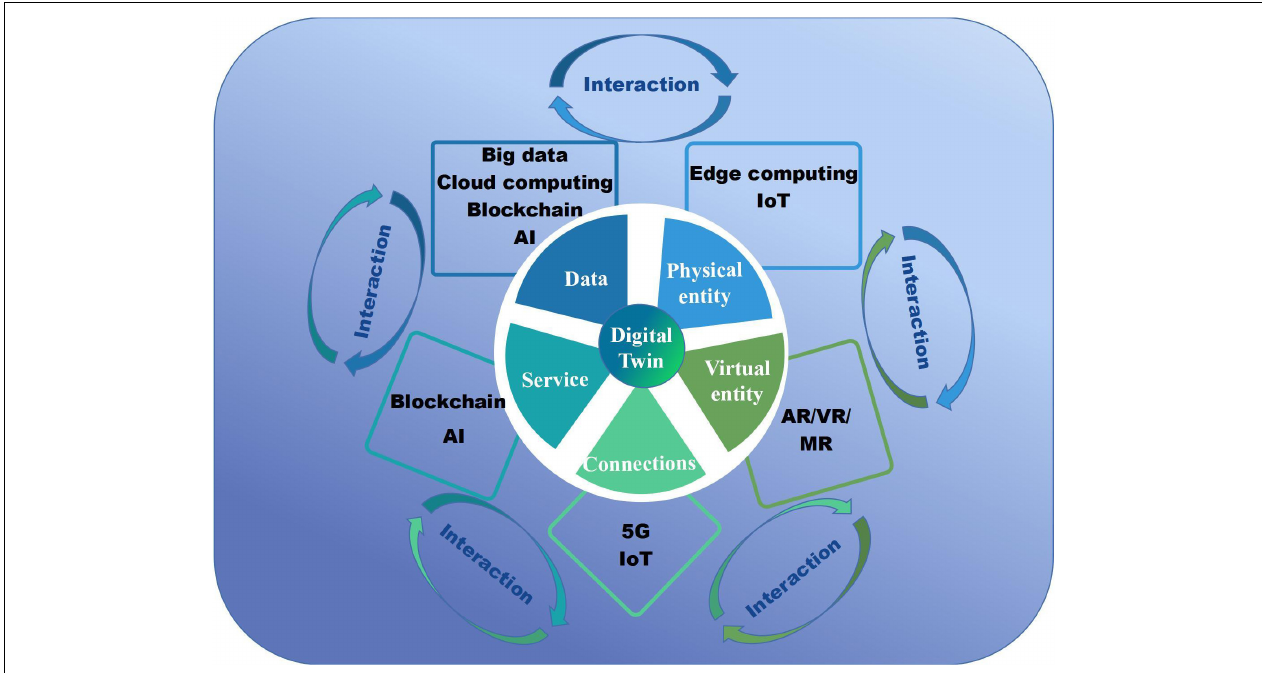
FIGURE 1 | Structural model and technical composition of digital